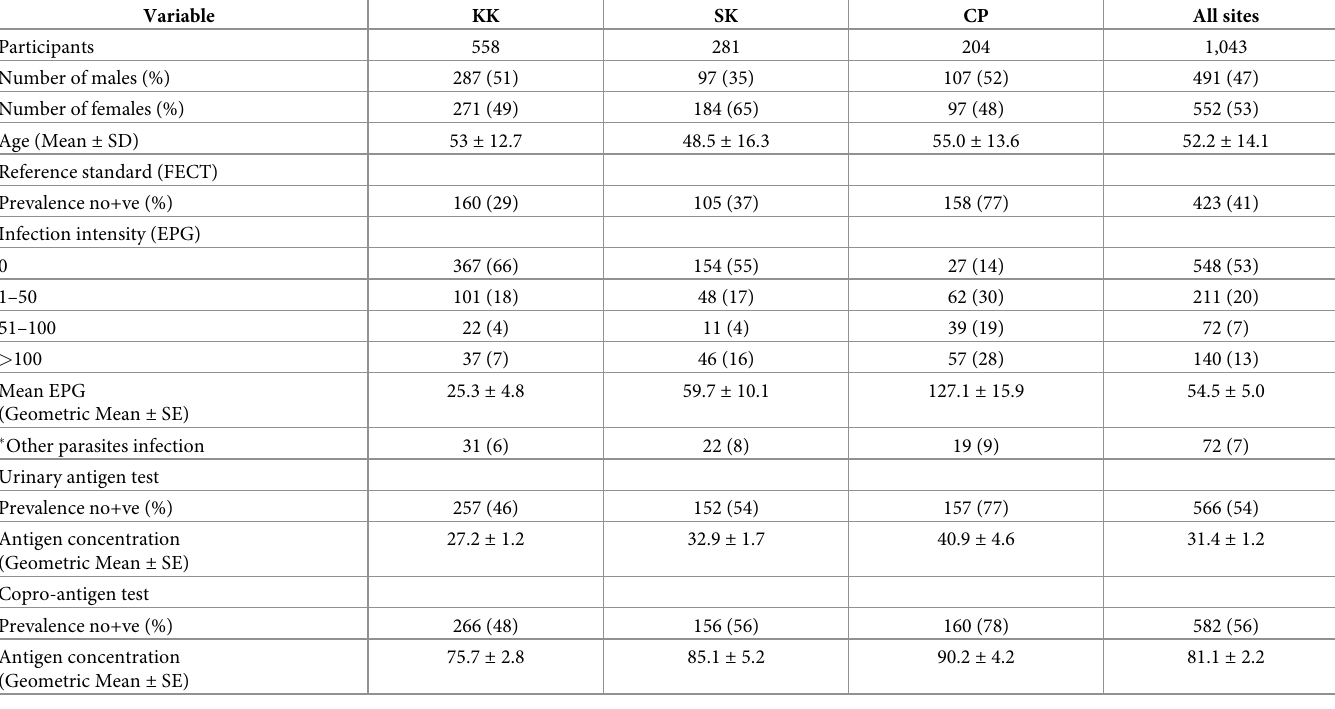
Table 1. Characteristics of study participants and the prevalence and intensity of O . viverrini determined by quantitative FECT, urine and copro-antigen detection in the study localities in northeast,